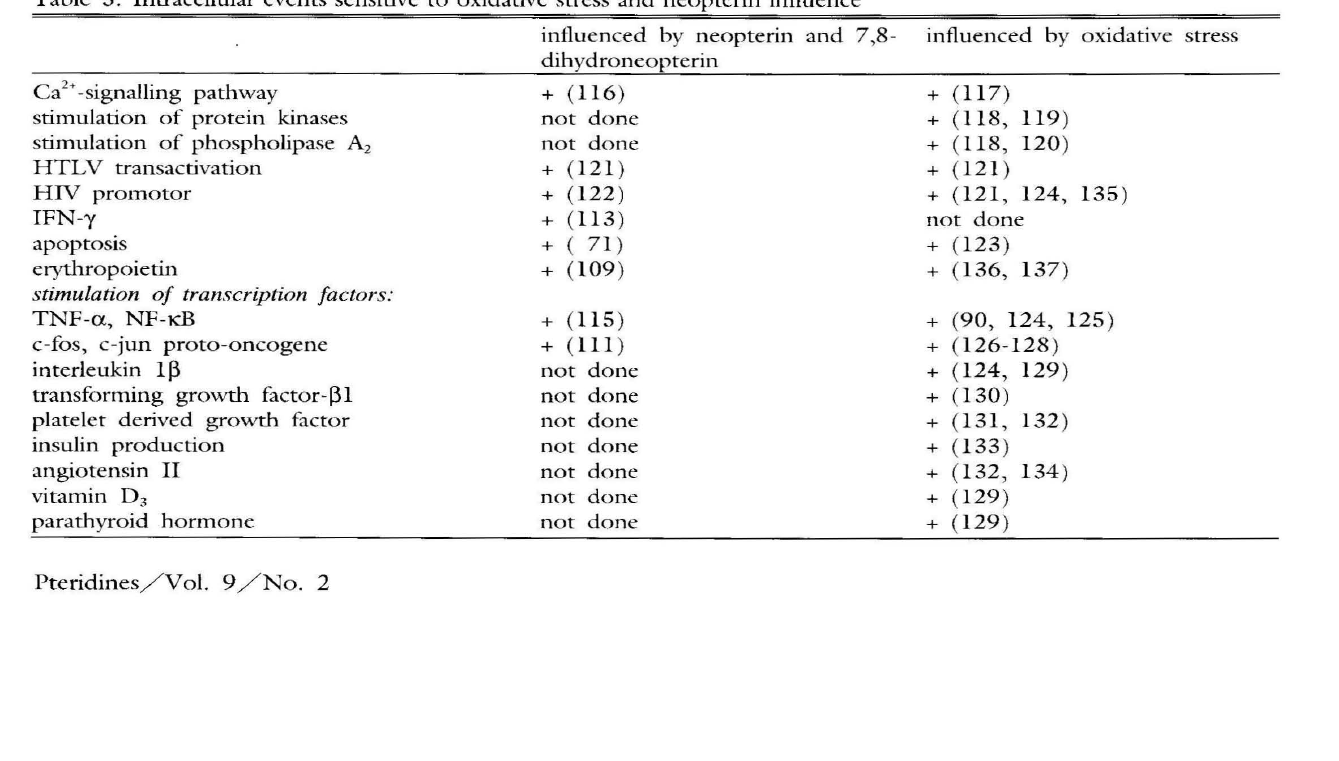
Table 3. Intracellular events sensitive to oxidative stress and neopterin